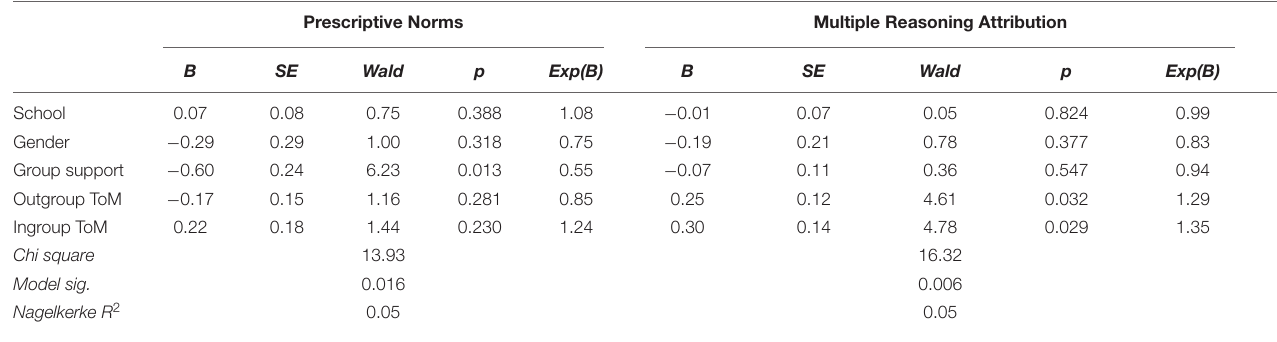
TABLE 4 | Binary logistic regression analyses for reasoning of acceptability judgments to intergroup